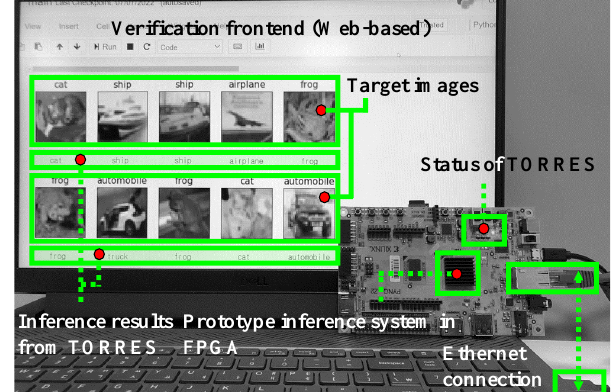
Figure 9. Environment setup for the functional